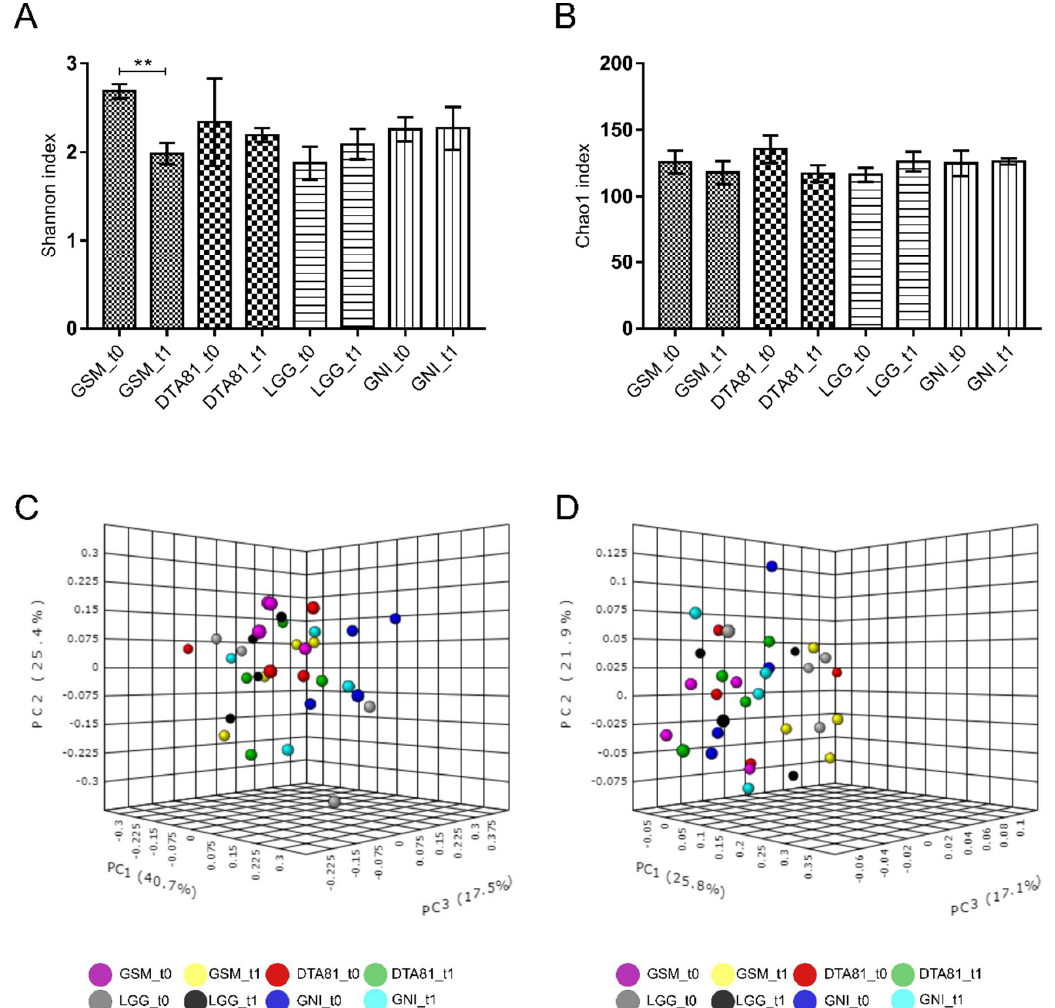
Figure 6. Bar charts comparing species diversity ( A ) and richness ( B ) between the different groups (GSM, DTA81, LGG, and GNI) before ( t 0) and after ( t 1) the experimental period. Values are means ± SEM ( n = 4). **, p ≤ 0.01. Principal coordinate analysis (PCoA) based on weighted ( C ) and unweighted ( D ) UniFrac distances for GSM, DTA81, LGG, and GNI in the time-points t 0 and t 1. Permutational multivariate analysis of variance (PERMANOVA) was carried out to detect significant dissimilarities among the different experimental groups.